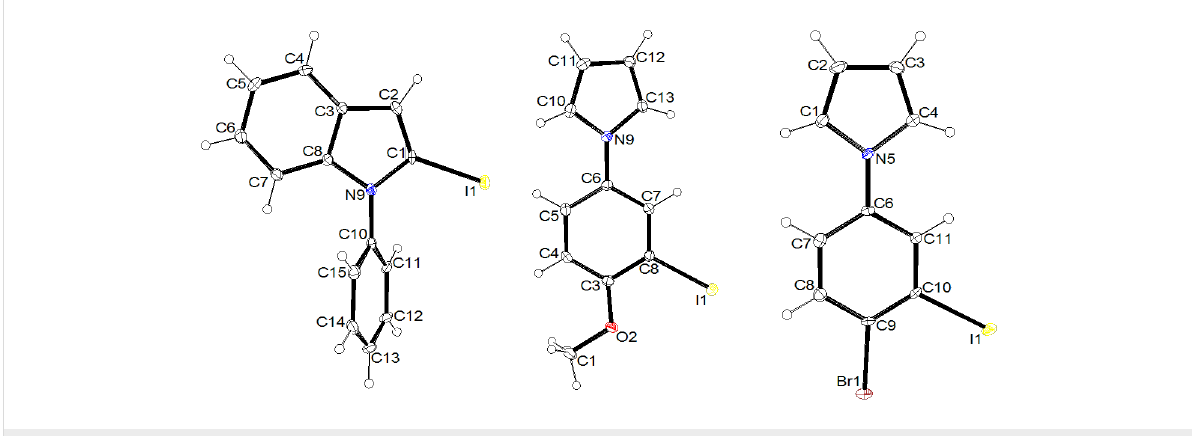
Figure 3: ORTEP diagrams (30% probability) of 4c , 3d and 3e .